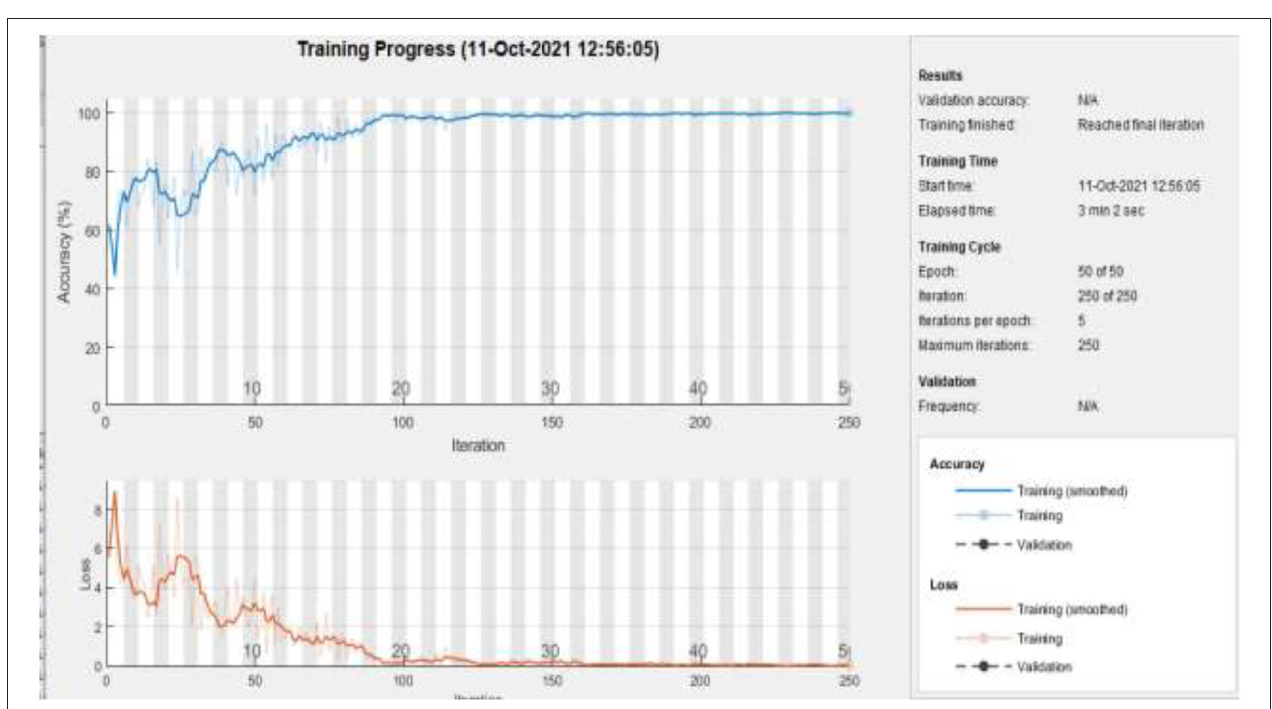
FIGURE 12 | Training of dataset A2 at 50